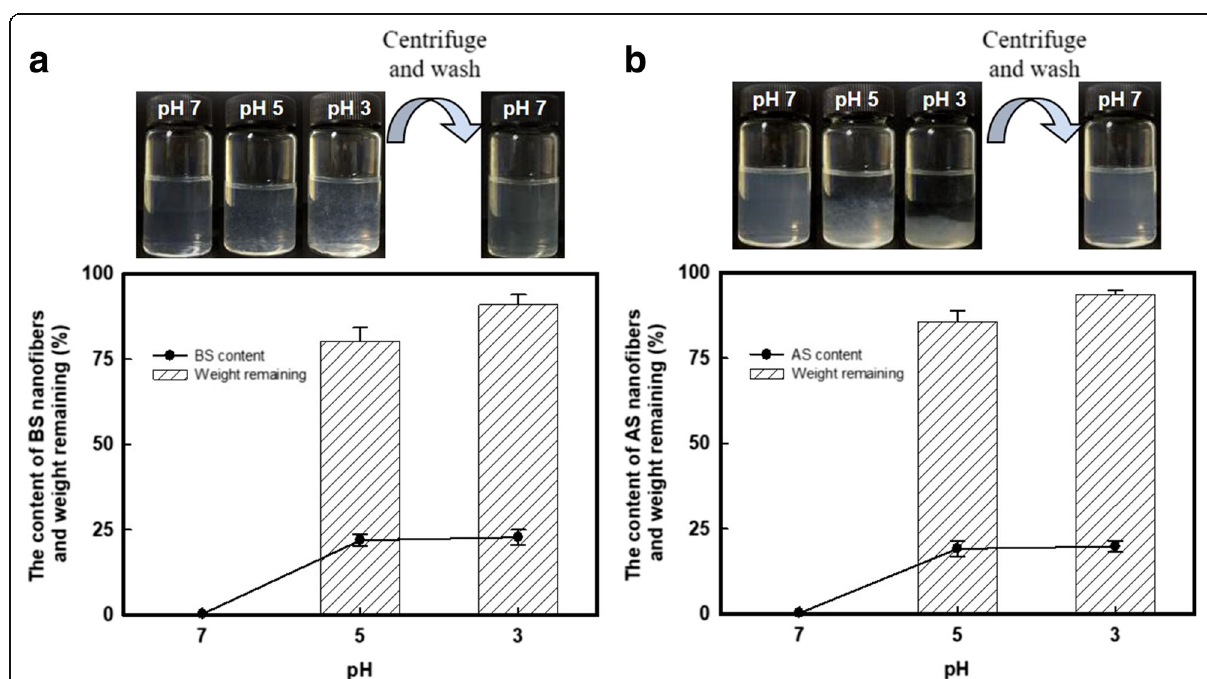
Fig. 5 Re-dispersing process of SNs. Photography of the pH response phenomenon for a BS and b AS nanofibers. Over 80 wt% of the proteins (both BS and AS) were remaining after centrifugation, with the protein content of ~ 20